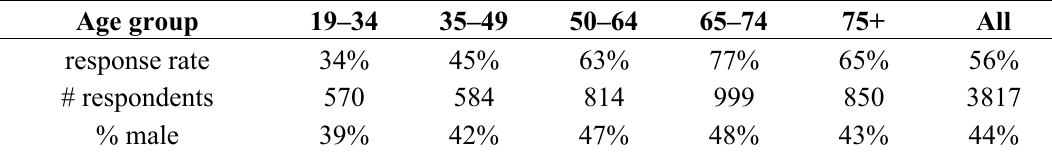
Table 1. Number of respondents per age group and percentage of male